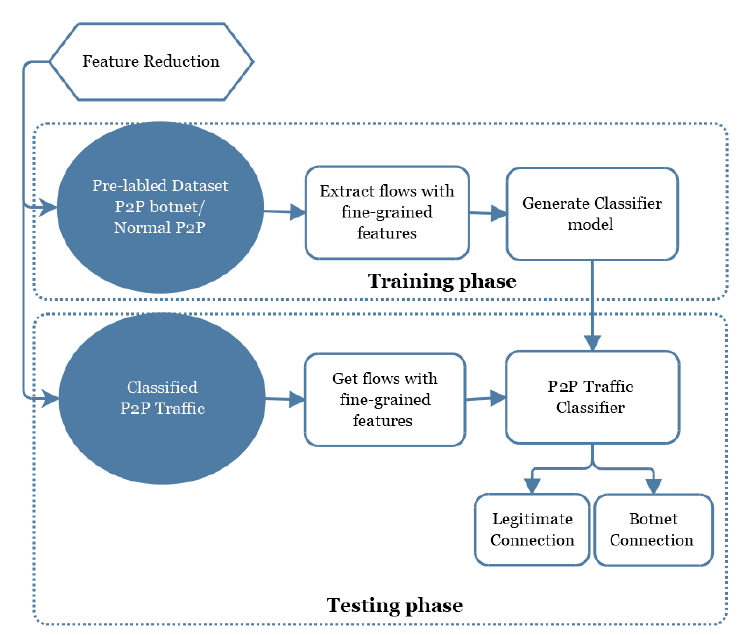
Figure 7. Fourth layer traffic classifier.